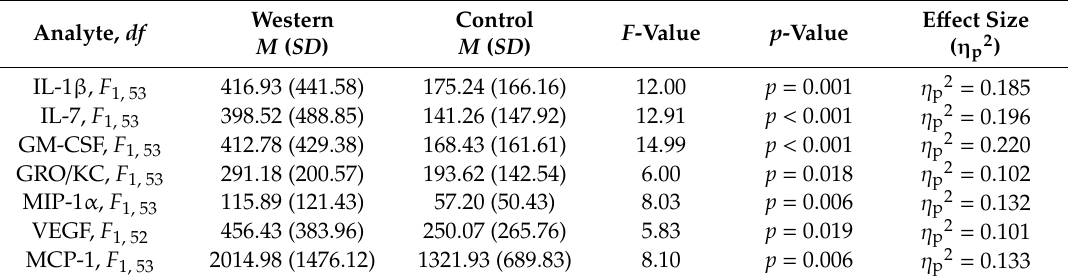
Table 5. Overview of diet main e ff ects for plasma inflammatory analytes from factorial ANOVA analyses for IL-1 β , IL-7, GM-CSF, GRO / KC, MIP-1 α , VEGF, and MCP-1, including means ( M ) and standard deviations ( SD ).